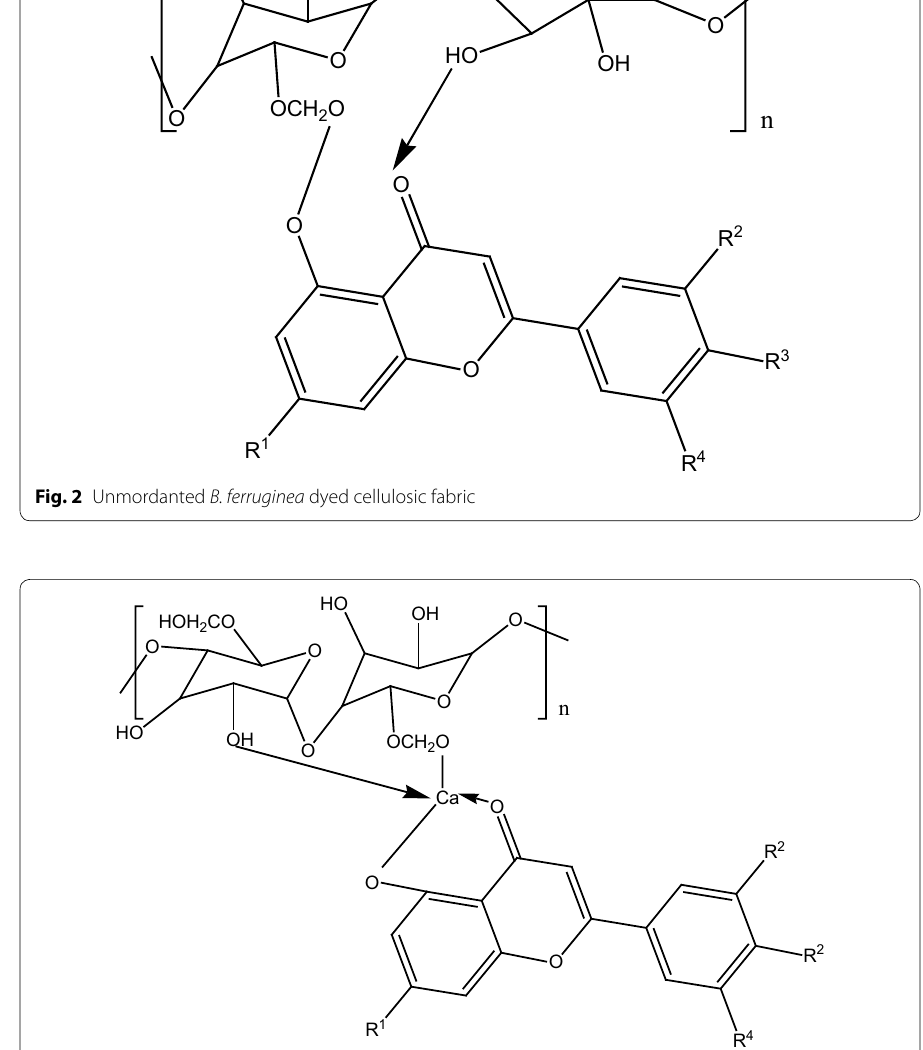
Fig. 3 Calcium chloride mordanted B. ferruginea dyed cellulosic